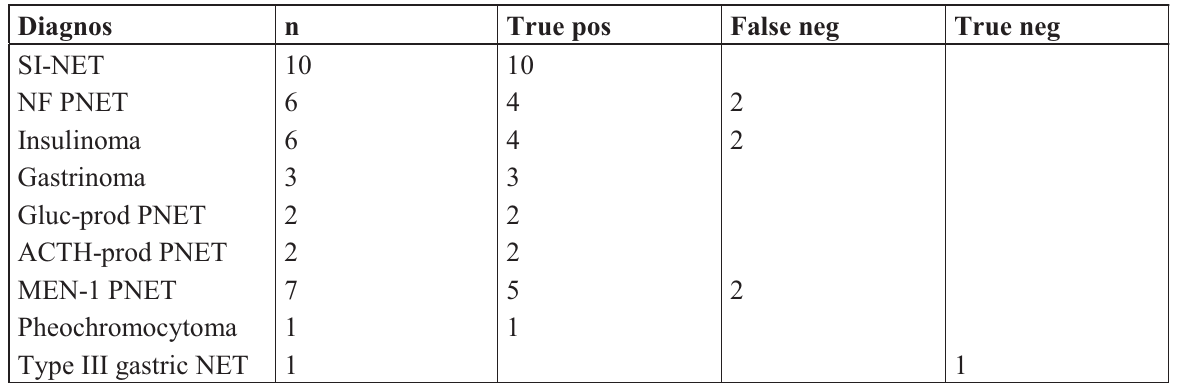
Table 1. List of diagnoses and 11 C-5-HTP PET results in correlation to findings at surgery and